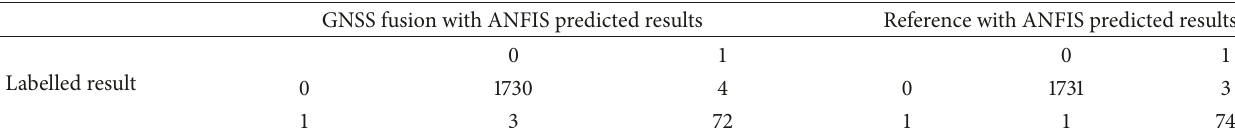
Table 2: Confusion matrix of the identification results.